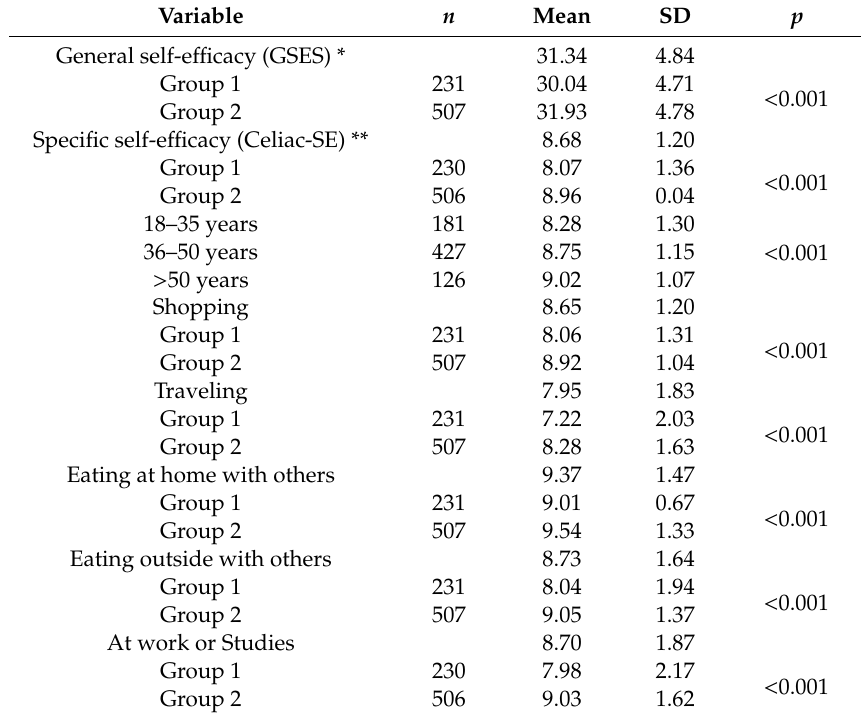
Table 3. General and specific self-e ffi cacy by adherence group, age group, and area of Celiac-SE ( n =